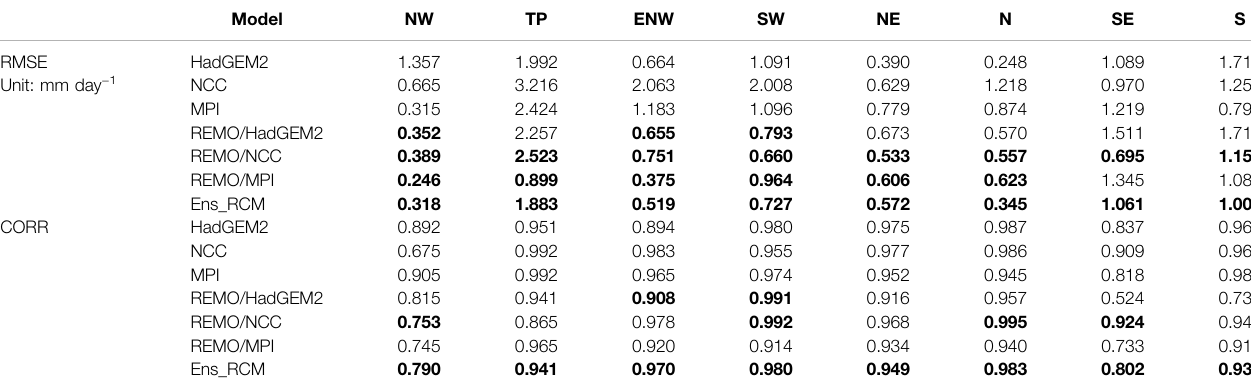
TABLE 2 | The RMSEs and the correlation coef fi cients between the simulation and the observation for the seasonal cycle of precipitation in the eight sub-regions.